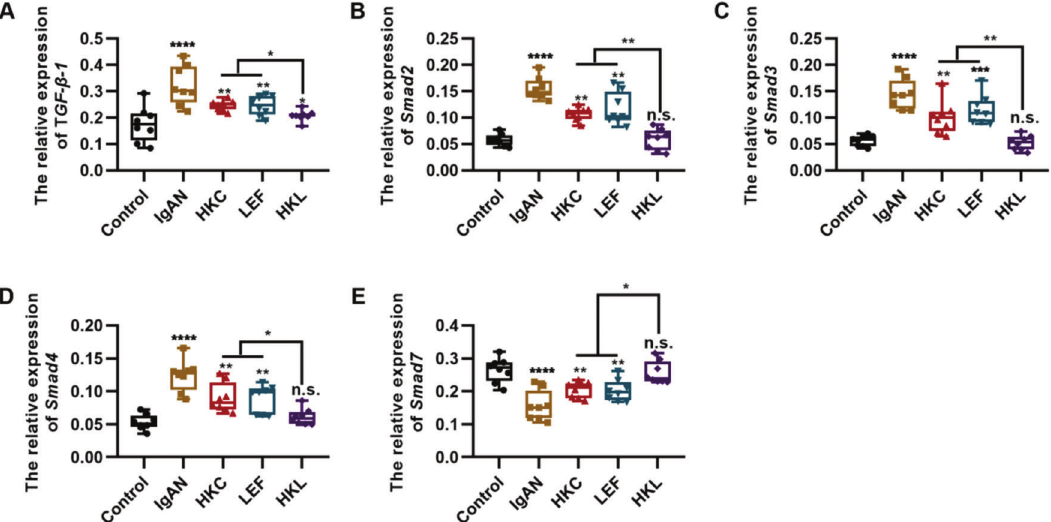
Figure 3 - HKL inhibits the expression of the TGF- b 1/Smad3 signaling pathway in IgAN rats. (A-D) Expression of TGF- b 1 (A), Smad2 (B), Smad3, (C), and Smad4 (D) in rats of all groups; (E) HKL upregulates the expression of Smad7 in IgAN rats. HKC: Huangkui capsule, LEF: leflunomide, HKL: HKC in combination with LEF, IgAN: Immunoglobulin A nephropathy, * p o 0.05, ** p o 0.001, *** p o 0.0001, and *** p o 0.0001, Kruskal–Wallis test followed by Dunn ’ s multiple comparisons